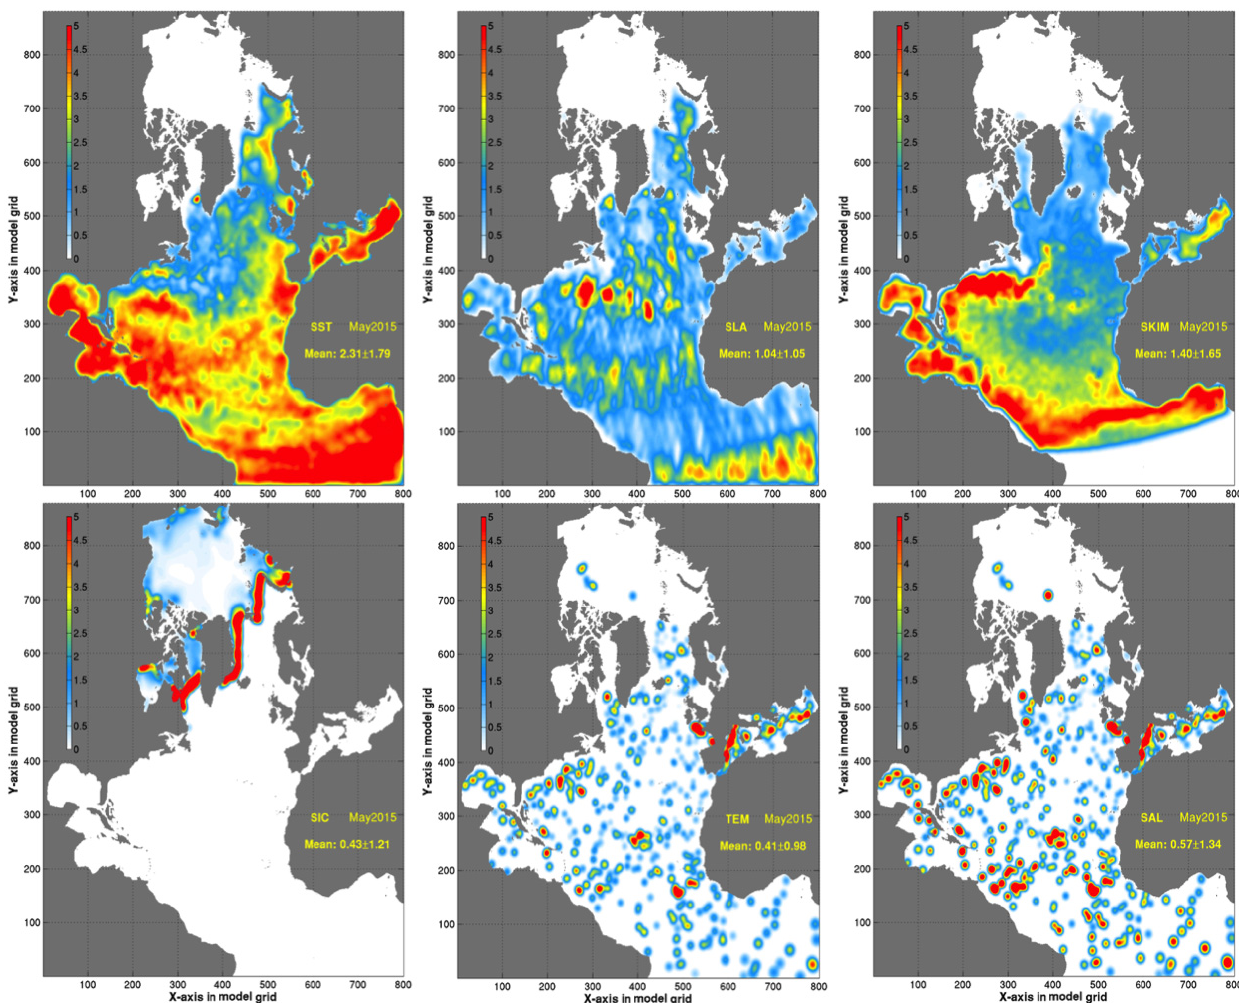
Figure 10. Degrees of freedom for signal of all assimilated observations over 1 week in May 2015. Top row from left to right: OSTIA sea surface temperature, CMEMS delayed-mode altimeter tracks and SKIM sea surface. Bottom row from left to right: OSI SAF sea ice concentrations and in situ (including Argo) temperature and salinity